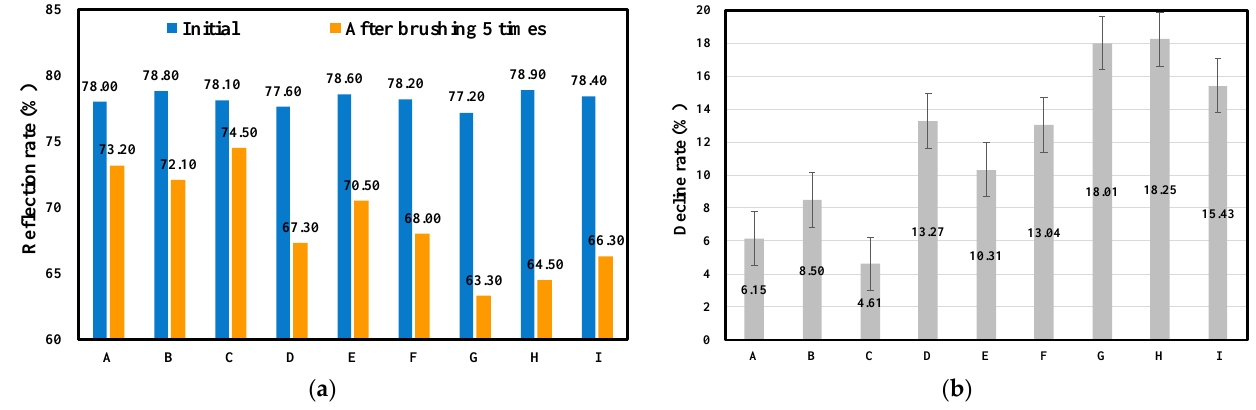
Figure 4. Design 1: ( a ) the change in the reflection rate and ( b ) the decline rate (after brushing 5 times).